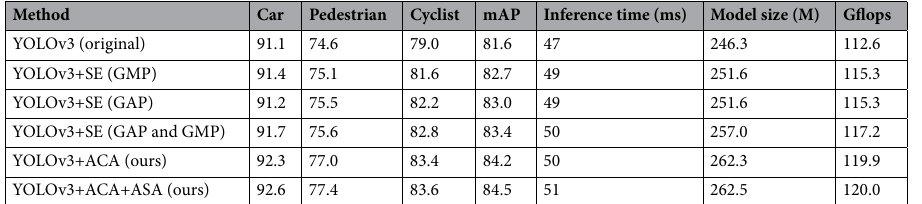
Table 1. Comparison of the proposed model with recent works on KITTI dataset.